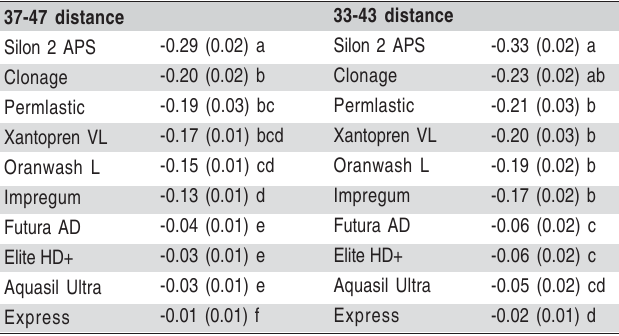
Table 2 - Dimensional change means and SD (%) of stone casts made with the elastomeric impression materials (transversal distances).